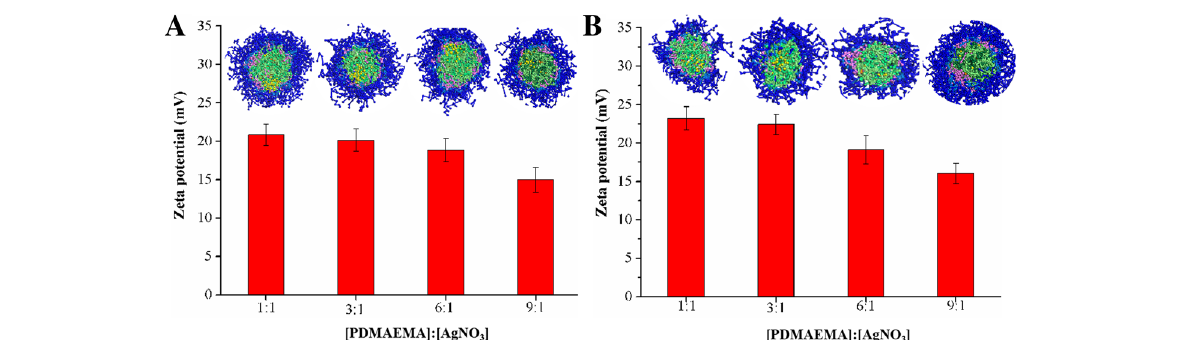
Fig. 2 The zeta potentials and the cross-section views of a linear and b star copolymers micelles stabilized AgNPs. The data was collected with different PDMAEMA/AgNO